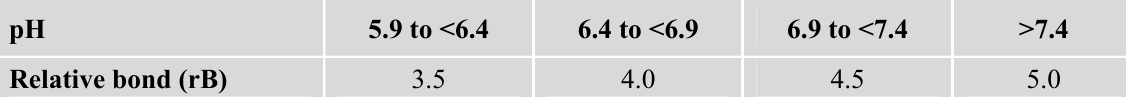
Table 2. Relative bond of cadmium in dependence on the pH-value